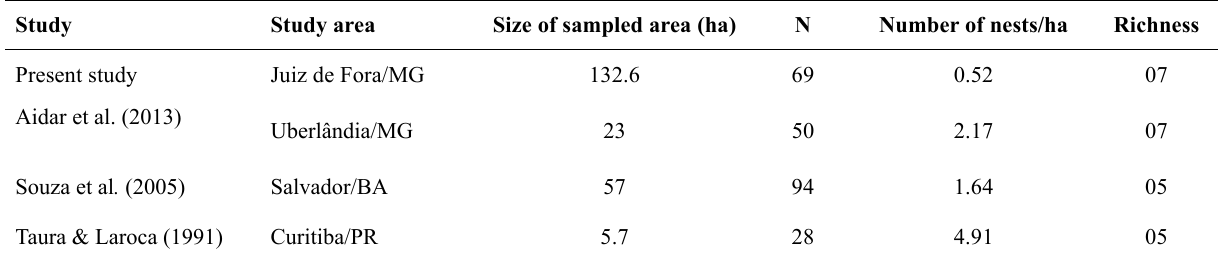
Table 2. Comparison of nesting attributes of stingless bees in the campus of the Federal University of Juiz de Fora and other studies in urban landscapes.